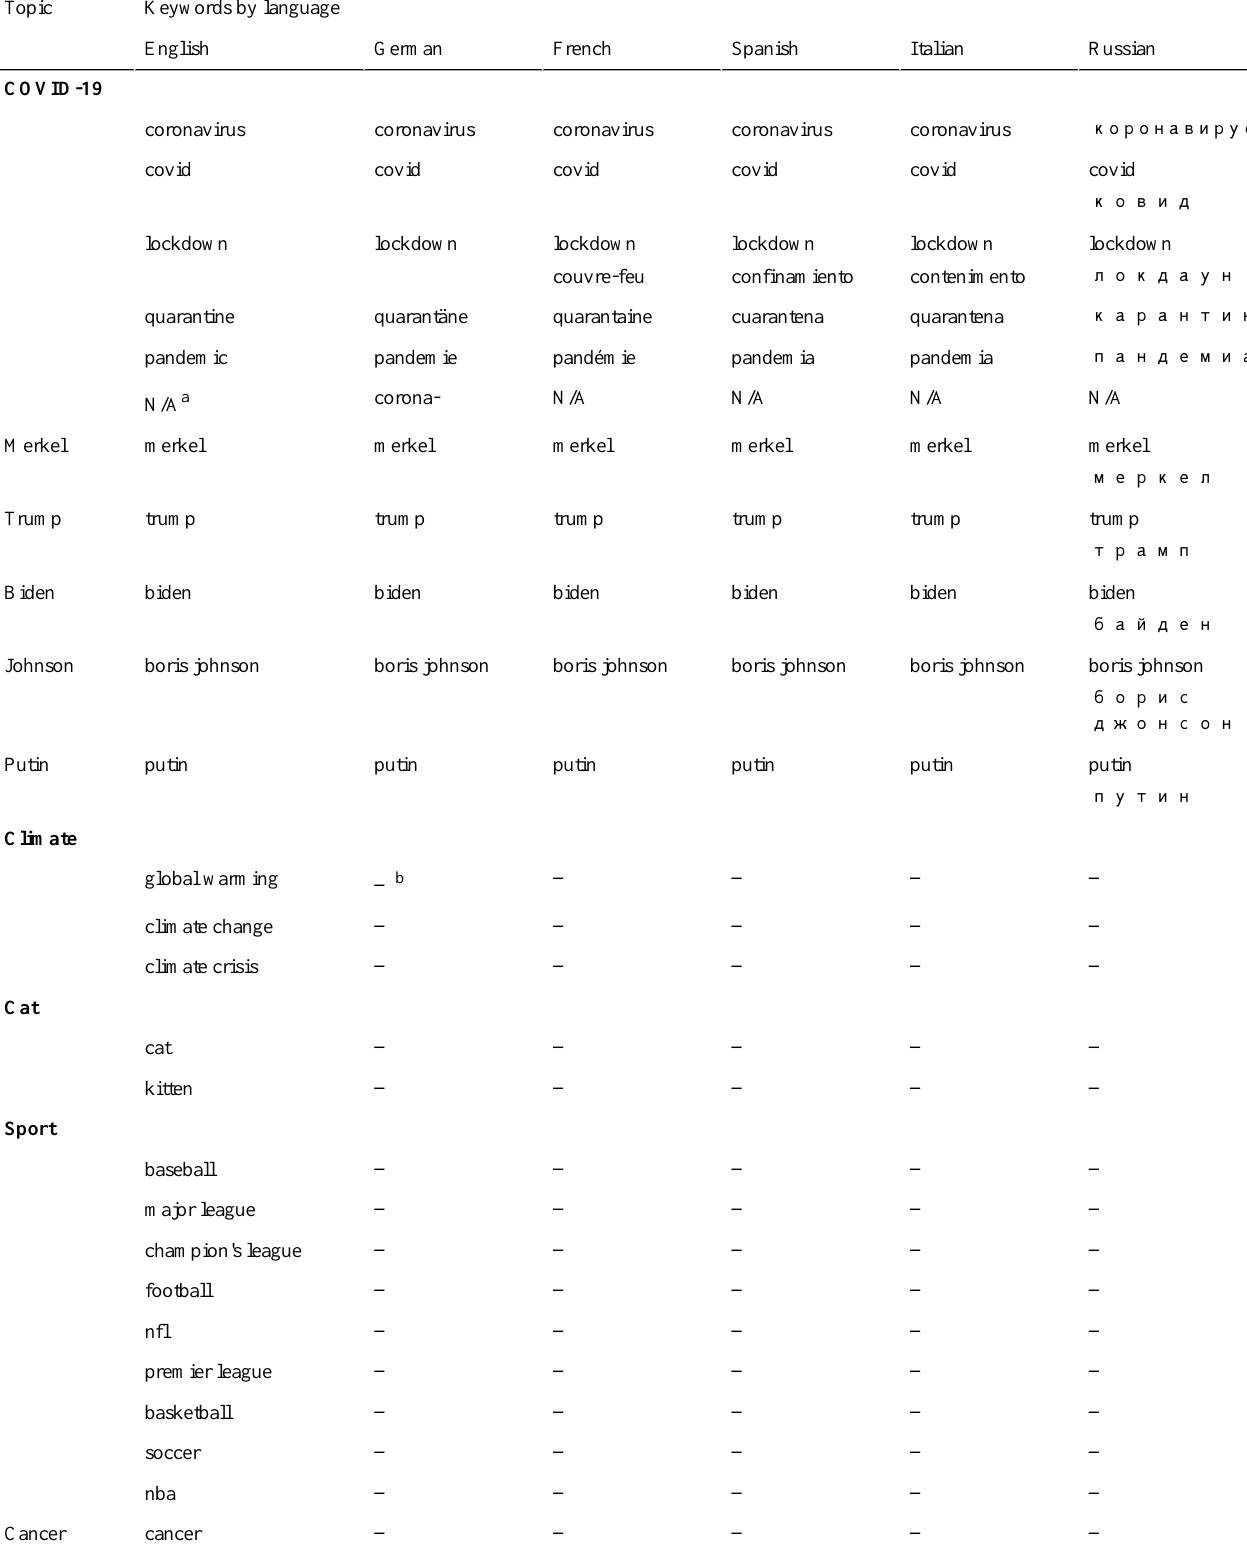
Table 2. Keywords employed for topic detection. Keywords by